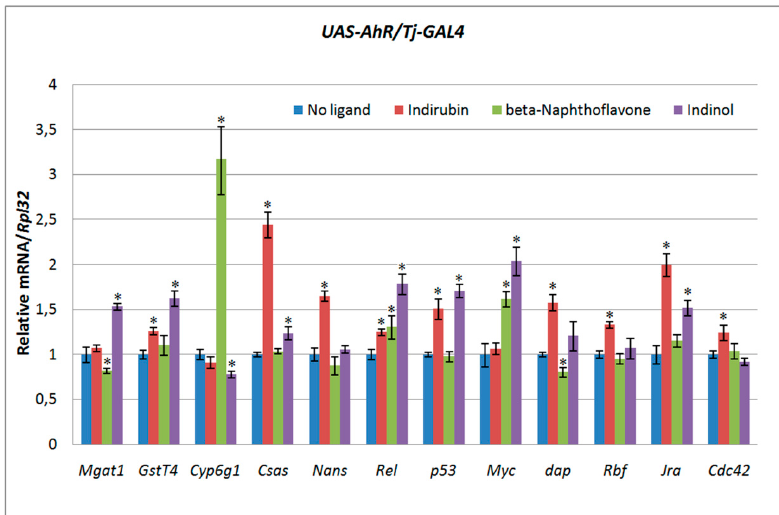
Figure 3. Different effects of human AHR exogenous ligands on AHR target gene mRNA levels in testes of UAS-AhR/Tj-GAL4 flies. Relative mRNA levels were analyzed by real-time PCR in testes dissected from UAS-AhR/Tj-GAL4 flies fed with indirubin, beta-Naphthoflavone or indinol for 2 days. UAS-AhR/Tj-GAL4 flies developed on standard medium were used as a control. Transcript levels are represented as means ± SD (error bars). * p < 0.05, compared to the control. Statistical analysis was performed using Student’s t -test.